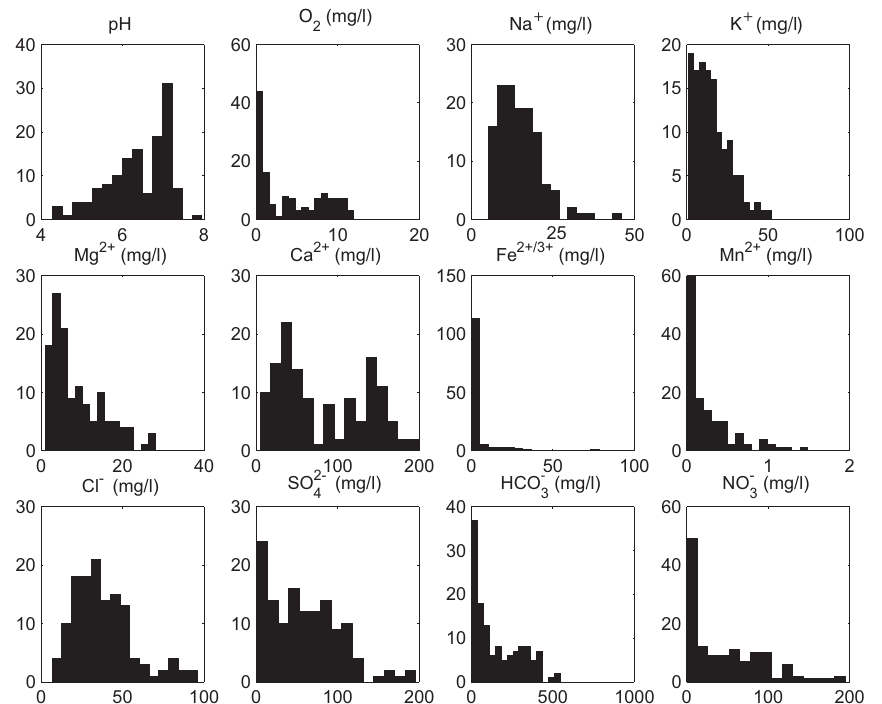
Fig. 6. Histograms of the hydrochemical data set.